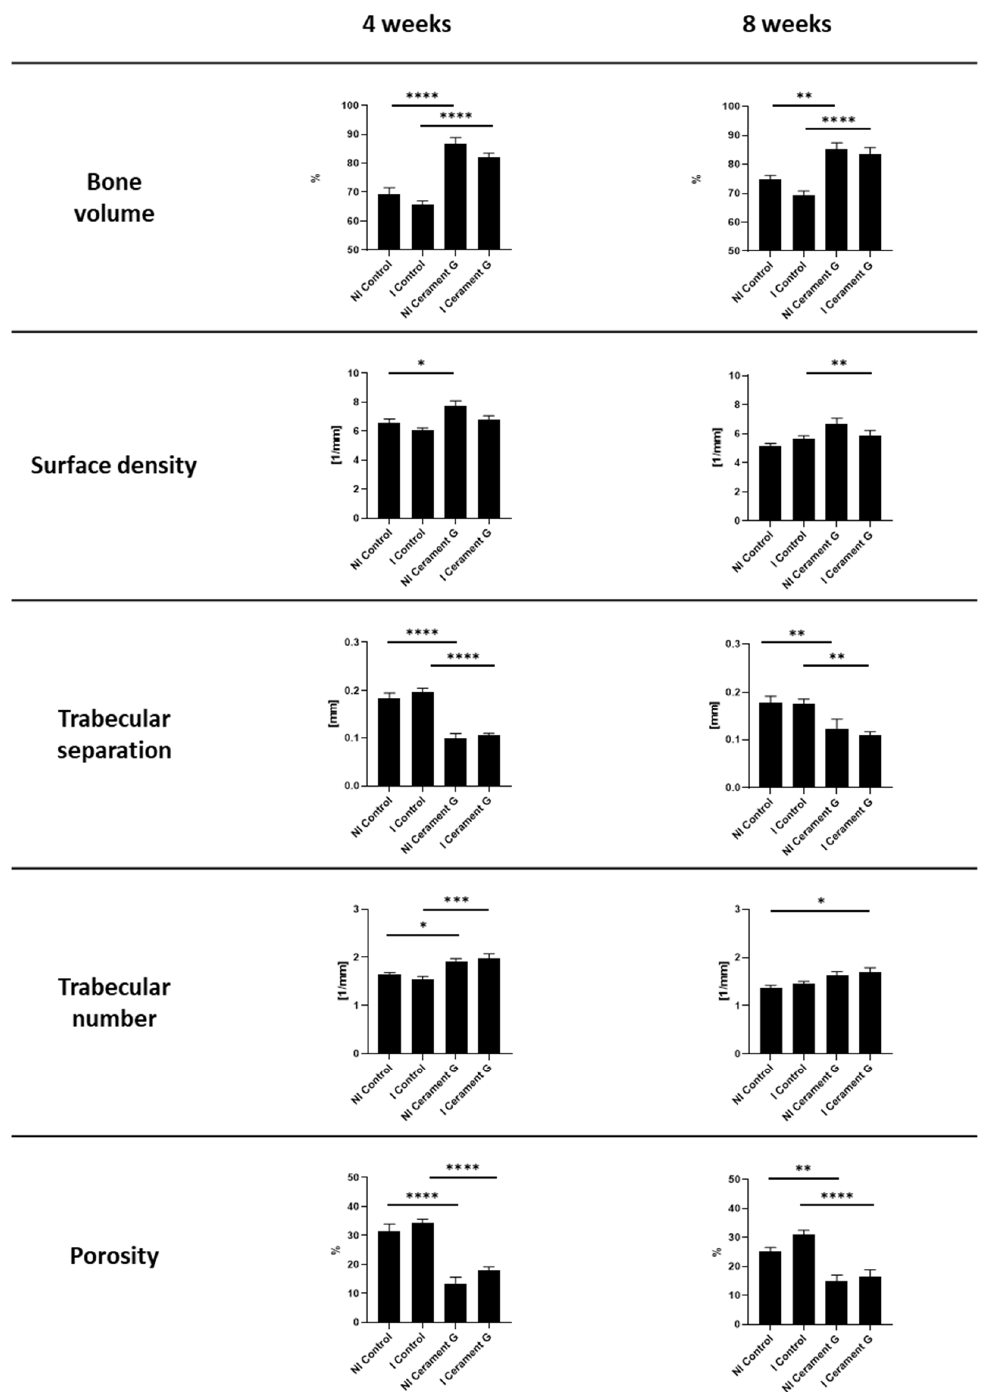
Figure 3. µCT Analysis of the bone 4 and 8 weeks after the second Surgery. **** = p < 0.0001, *** = p < 0.001, ** = p < 0.01, * = p < 0.05, ns = not significant.